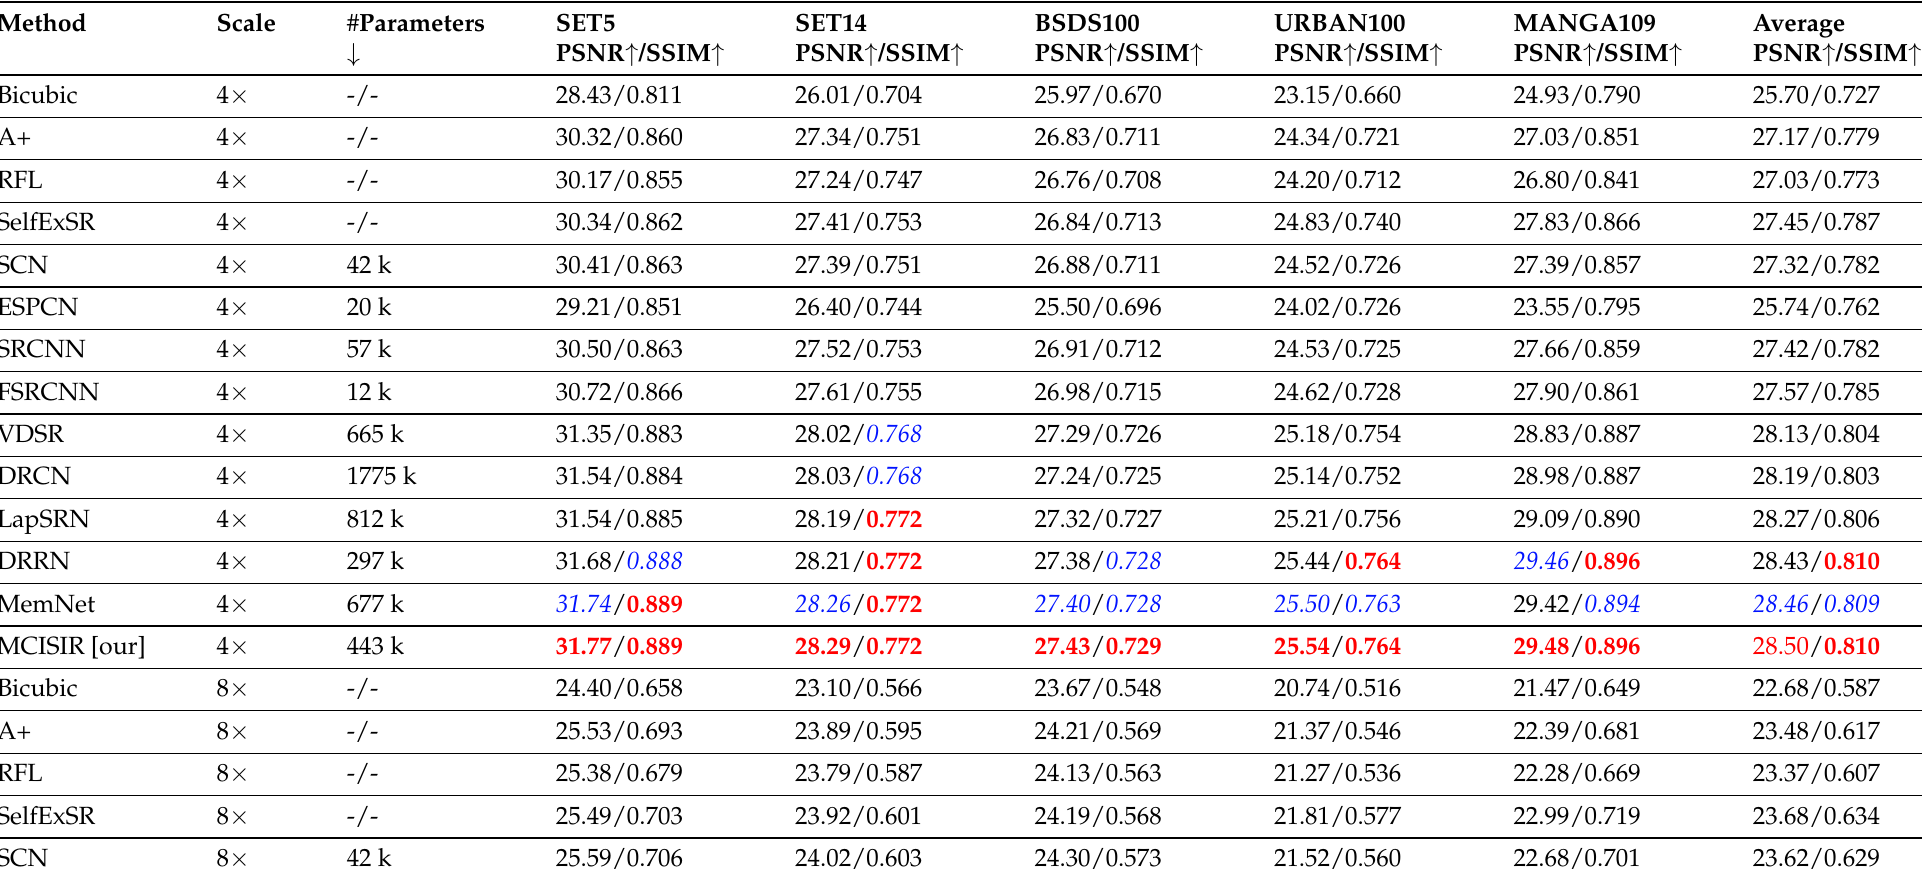
Table 1. Quantitative comparison of PSNR/SSIM of recent image super-resolution methods on challenging enlargement factor 4 × and 8 × . The first best result is indicated by bold with red color and the second-best result is described by blue